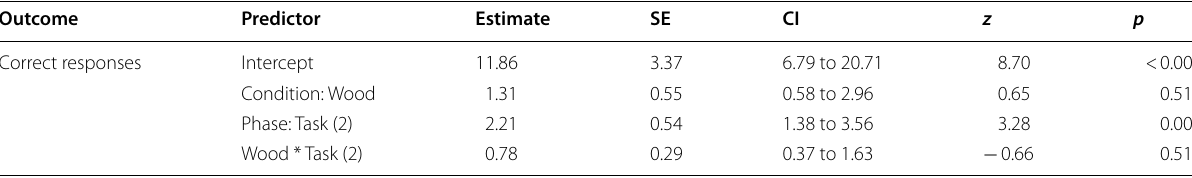
The estimates represent odds ratios. Significant predictors ( p < 0.05) are shown in bold SE: standard error; CI: confidence interval; z : test statistic z ; p : p -value